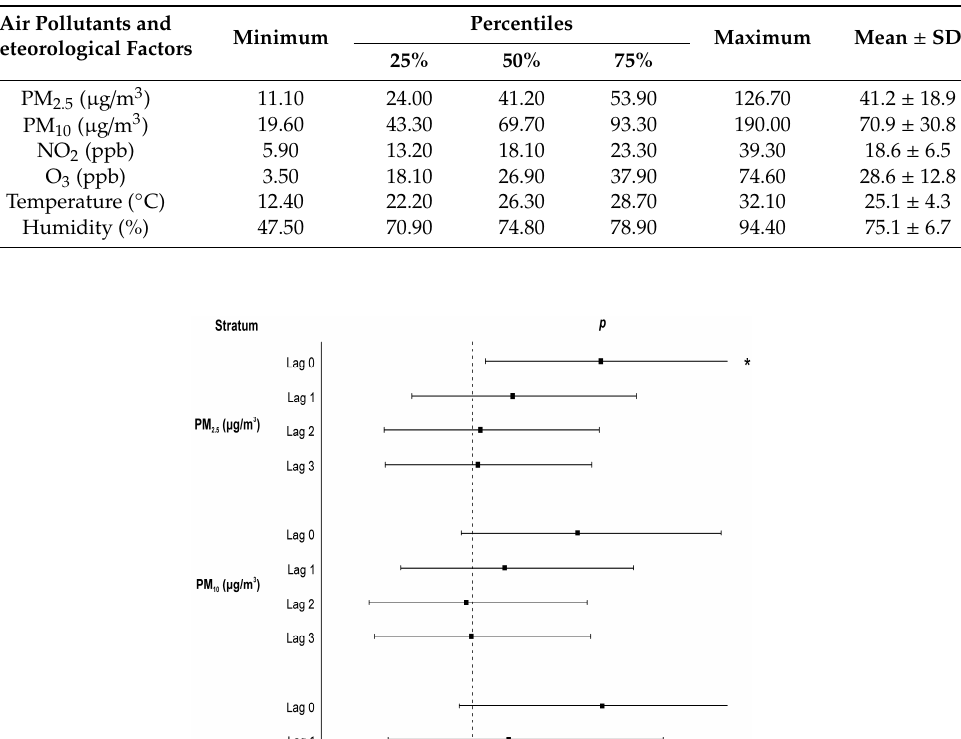
Table 2. Summary statistics for meteorological factors and air pollution in Kaohsiung, 2011–2016. PM: Particulate matter.